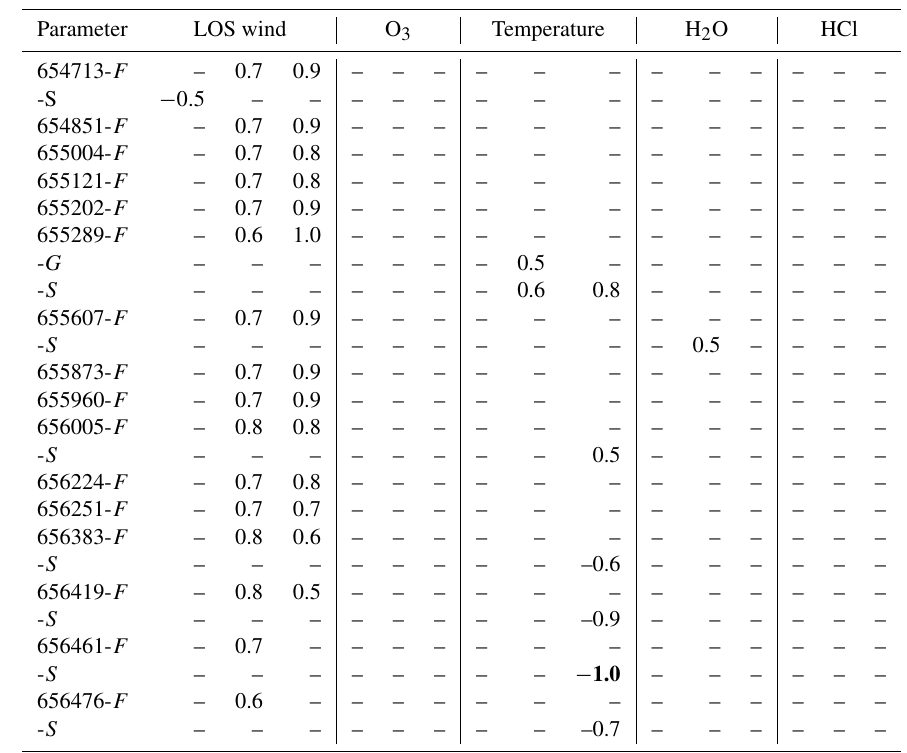
Table A2. Continuation of Table A1.